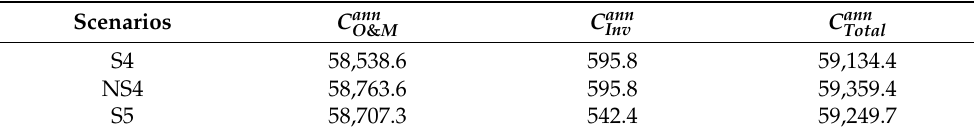
Table 4. Costs of S4, NS4 and S5 configuration schemes.